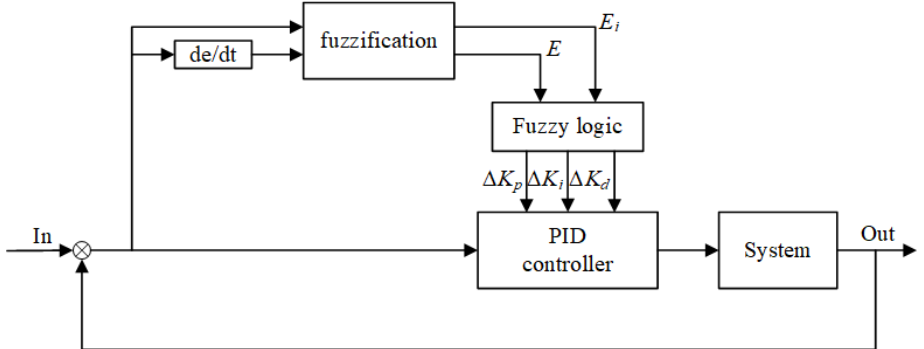
Figure 4. Fuzzy PID controller